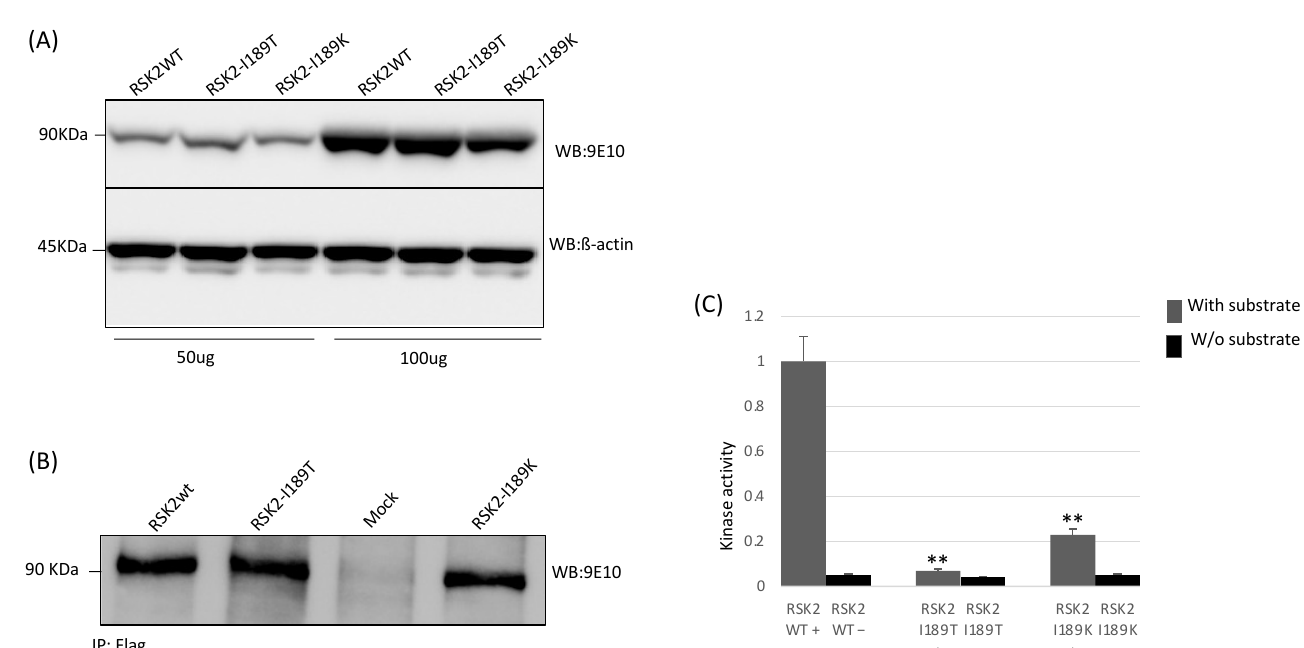
Figure 3. ( A ) Western blot analysis of transient transfection of cDNAs RSK2 wt., RSK2–I189T, RSK2–I189K, with 50 ug and 100 ug of loading proteins; ( B ) immunoprecipitation of equal proteins amount of wt., mutated proteins, and negative control (Mock); ( C ) measure of phosphotransferase activity from RSK2 wt., RSK2–I189T, RSK2–I189K proteins by kinase assay using S6 peptide, a standard RSK2 in vitro substrate. RSK2 was immunoprecipitated kinase assay with (+) and without ( − ) RSK2 substrate. Experiments were repeated three times with independently prepared cell extracts. ** p (value) <